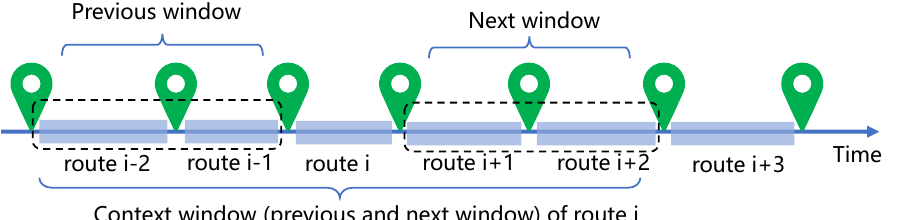
Figure 5. An instance of the context window of a trajectory. The window includes 4 routes visited before and after the i th